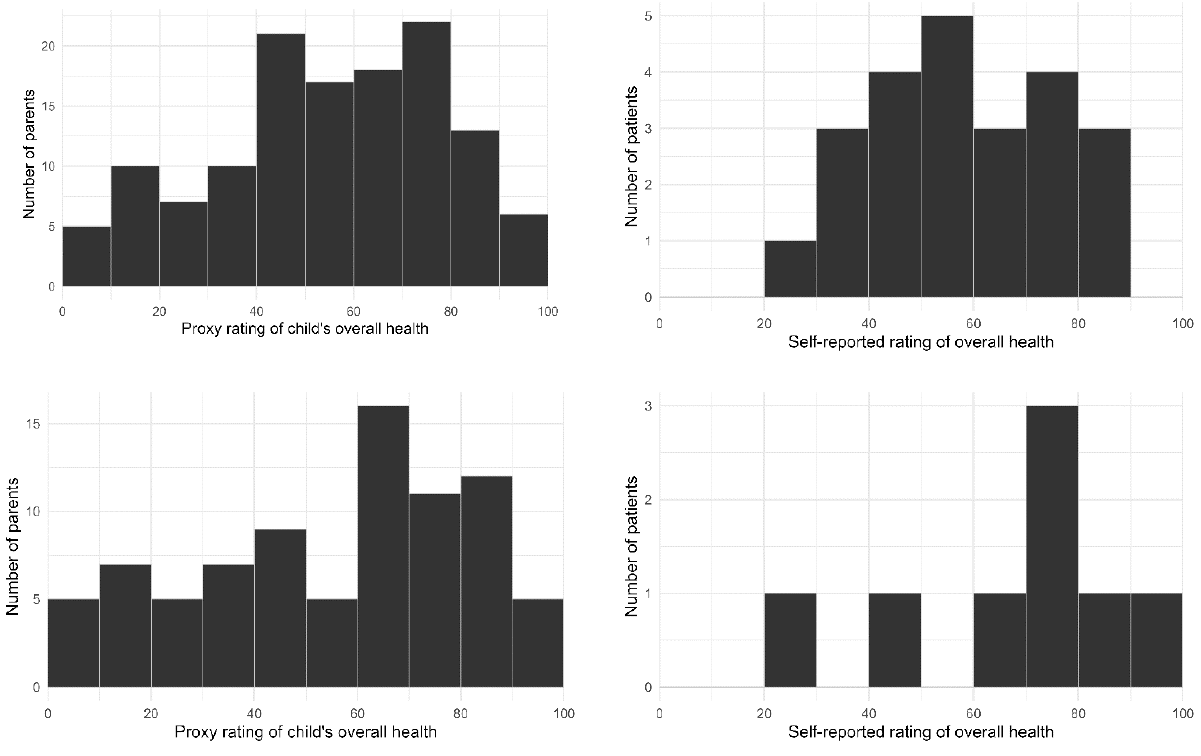
Figure 2. Patient self-report and parent-proxy QoL on EQ-5D-Y domains at T0 and T1.